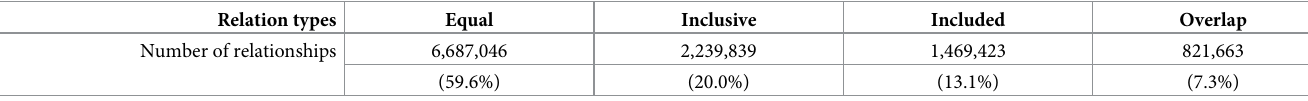
Table 8. The Relationships between clauses and clinical